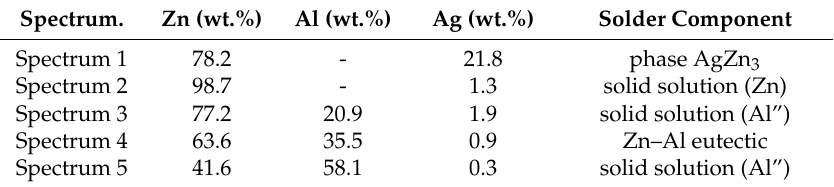
Figure 7. EDX analysis of soldering alloy type Zn–Al–Ag. Table 4. The phase composition results of Zn-Al-Ag solder.